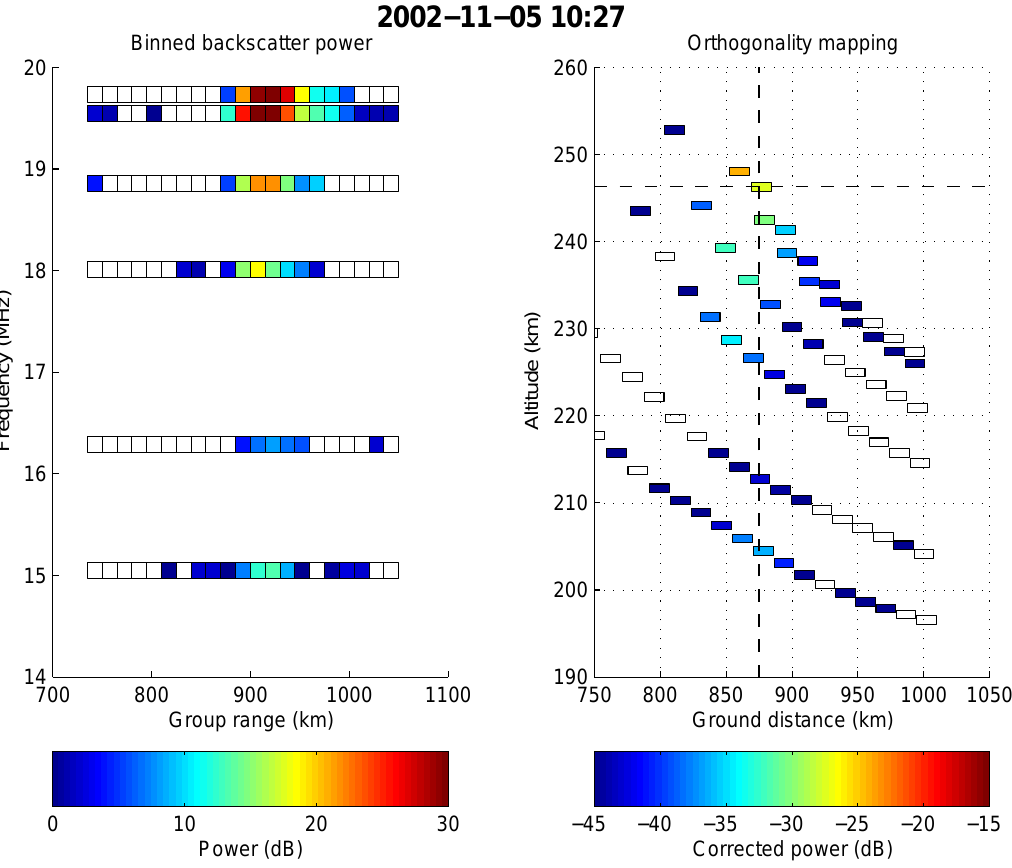
Fig. 5. The same as Fig. 4 but for the pump cycle beginning at 10:27 UT. Note that on the two highest frequencies, not all of the gates where strong scatter is detected in the left panel are mapped in the right